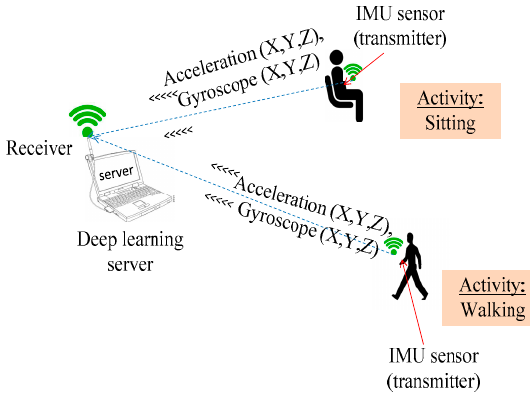
Figure 2. Data collection architecture.